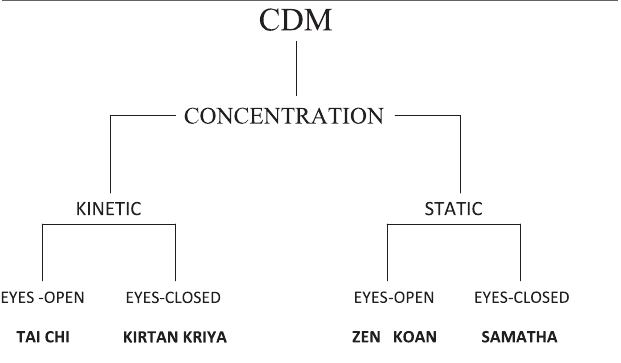
Table 2 | Sub-classification of four different cognitive-directed